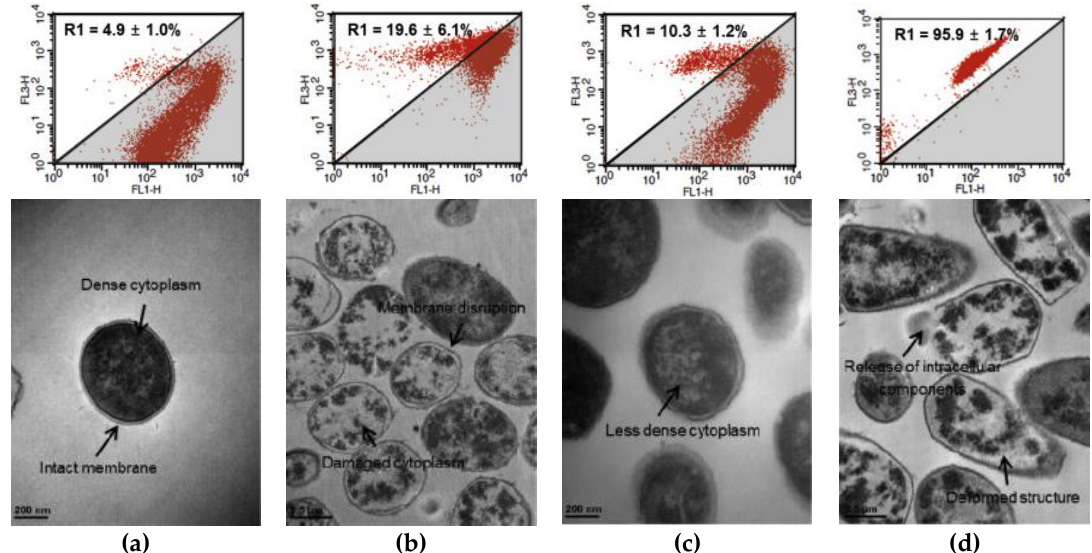
Figure 3. Comprehensive analysis of flow cytometry plots and TEM images for demonstrating the mode of action for the synergistic e ff ects of essential oil-based antibacterial complex against Staphylococcus aureus treated with singular treatment (carvacrol or NaCl) and combined treatment (carvacrol + NaCl): control (untreated cells) ( a ), singular treatment of carvacrol (2.0 mM) ( b ), singular treatment of NaCl (15.0%) ( c ), carvacrol (2.0 mM) + NaCl (15.0%) ( d ). This figure was adopted from previous research reported by Kim et al. [44].